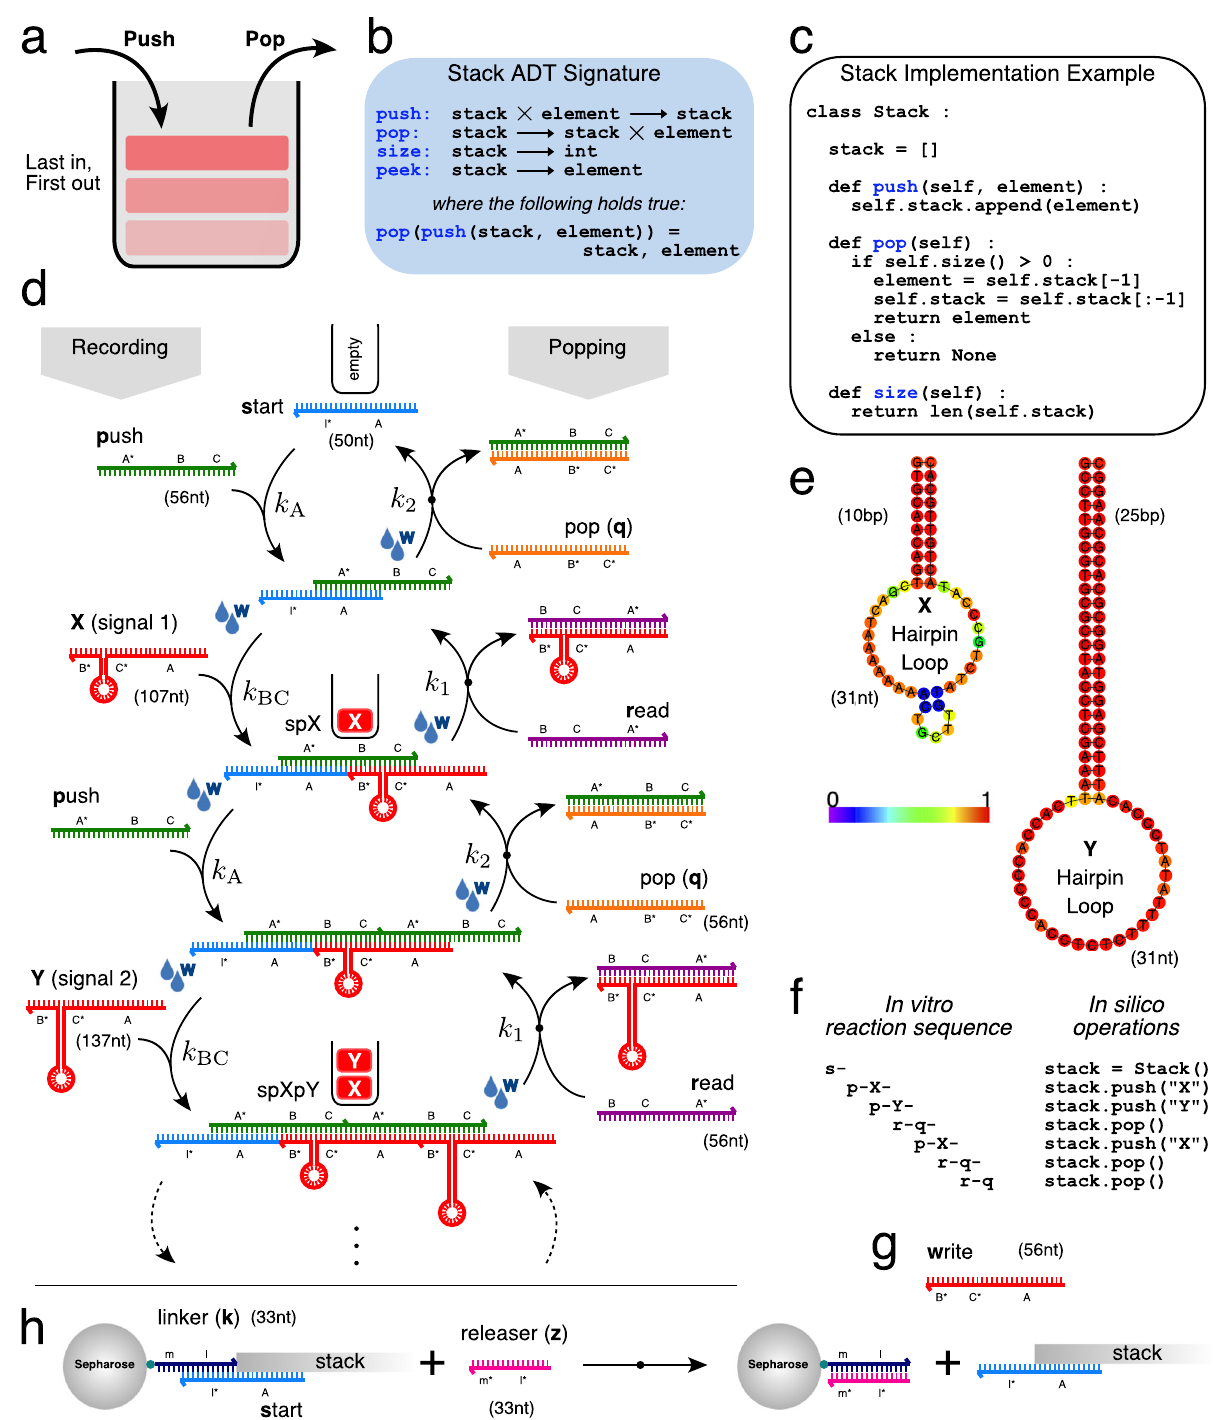
Fig. 1 A last-in fi rst-out stack data structure implemented in vitro with nine short ssDNA strands and operated at room temperature. a Principle of a last-in fi rst-out data structure; the last data item “ pushed ” is the fi rst one “ popped ” . b Formal speci fi cation of a stack as an Abstract Data Type. c A minimal stack implementation in Python (omitting peek() ). d DNA reaction network implementation of a stack recording two signal types, X and Y . Hybridisation reactions result in polymerisation and recording of signals X and Y (left side). Conversely, strand displacement reactions (arrows with black dots) reverse polymerisation to retrieve signals in the order opposite to which they were recorded (right side). Domains marked as * are reverse complements, W denotes washing step (see text). e Secondary structure prediction of hairpin loops distinguishing X and Y signals (ViennaRNA: colour bar indicates base pairing probability). f Correspondence between in vitro DNA stack reaction sequence and in silico Python stack function calls push() and pop() . g Linear signal w (no hairpin loop) used to create a DNA stack system amenable to PAGE analysis and model fi tting (see text). h Hybridisation/strand displacement method of tethering/releasing stack complexes to/from sepharose beads during washing procedure.